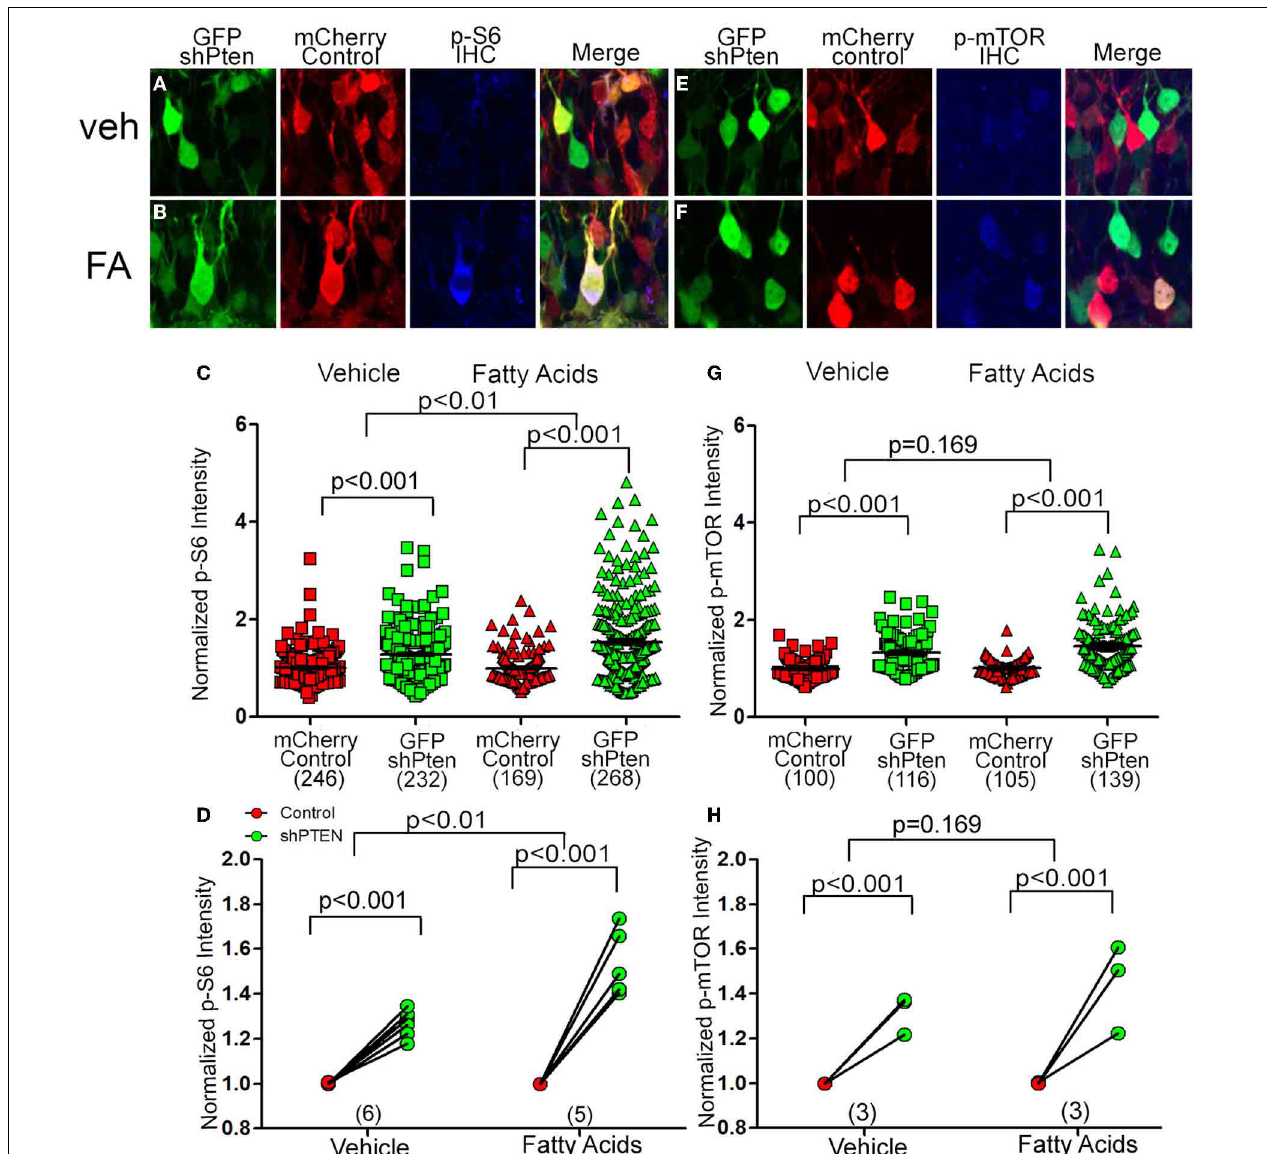
FIGURE 5 | Circulating fatty acids increase p-S6 and p-mTOR signaling in Pten knockdown neurons. Adult animals were co-injected with the Pten knockdown lentivirus (GFP shPten; green) and the mCherry expressing control virus (mCherry control; red). Mini-osmotic pumps were implanted seven days post-injection and then seven days after implantation immunohistochemistry was used to evaluate p-S6 or p-mTOR expression (blue). (A) A slight increase in p-S6 expression (blue) was detected in Pten knockdown neurons (green) when compared to control neurons (red) in vehicle treated animals. (B) In animals treated with fatty acids, a marked increase in p-S6 staining (blue) was observed in the GFP shPten cells (green) when compared to the mCherry control cells (red only). (C) Plot of individual p-S6 intensities for each knockdown and control neuron normalized to the p-S6 intensity in controls. (D) Pten knockdown resulted in an increase in p-S6 signaling in knockdown neurons compared to controls in the vehicle control as well as the fatty acid treatment groups (mCherry control Veh = 1 . 0 ± 0 . 02, GFP shPten Veh = 1 . 28 ± 0 . 03, p < 0 . 001, n = 246 and 232 neurons from 6 animals. mCherry control FA = 1 . 0 ± 0 . 02, GFP shPten FA = 1 . 54 ± 0 . 05,